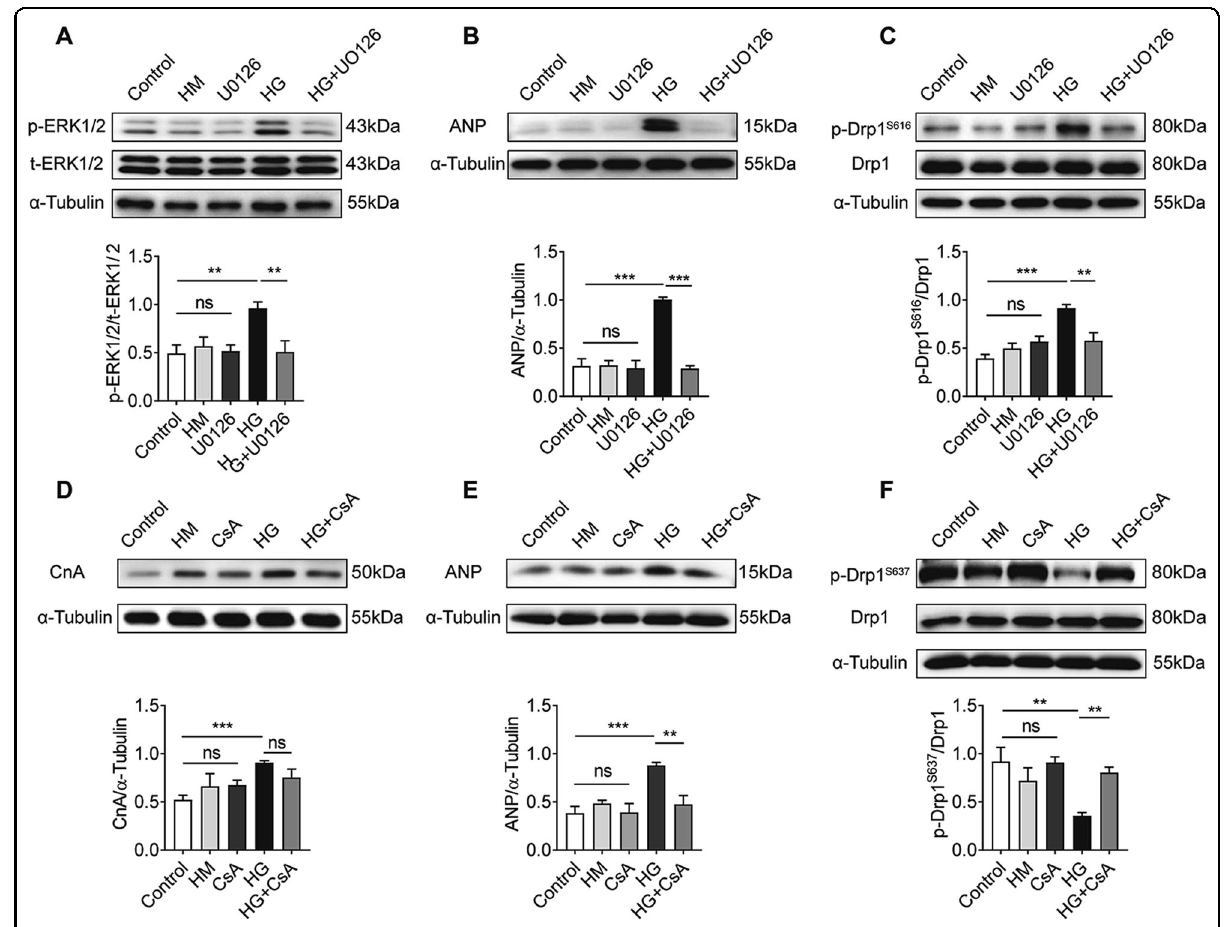
Fig. 7 CnA and p-ERK1/2 contribute to HG-induced cardiomyocyte hypertrophy by regulating Drp1 phosphorylation. A Changes in p-ERK1/ 2 levels in NRCMs treated with U0126 at 10 μΜ . Protein levels of p-ERK1/2 were normalized by total ERK1/2 ( n = 4). B Changes in ANP levels in NRCMs treated with U0126 at 10 μ M ( n = 7). C Changes in p-Drp1 S616 levels in NRCMs treated with 10 μΜ U0126. The protein level of p-Drp1 S616 was normalized by total ERK1/2 ( n = 6). D Changes in CnA levels in NRCMs treated with 10 μΜ CsA ( n = 3). E Changes of ANP level in NRCMs treated with CsA at 10 μ M ( n = 5). F Changes in p-Drp1 S637 levels in NRCMs treated with 10 μΜ CsA. Quanti fi cation of Drp1 phosphorylation at S637 corrected for total Drp1 ( n = 4). Data are shown as mean ± SEM. * P < 0.05, ** P < 0.01, and *** P < 0.001; n.s. no signi fi cant statistical